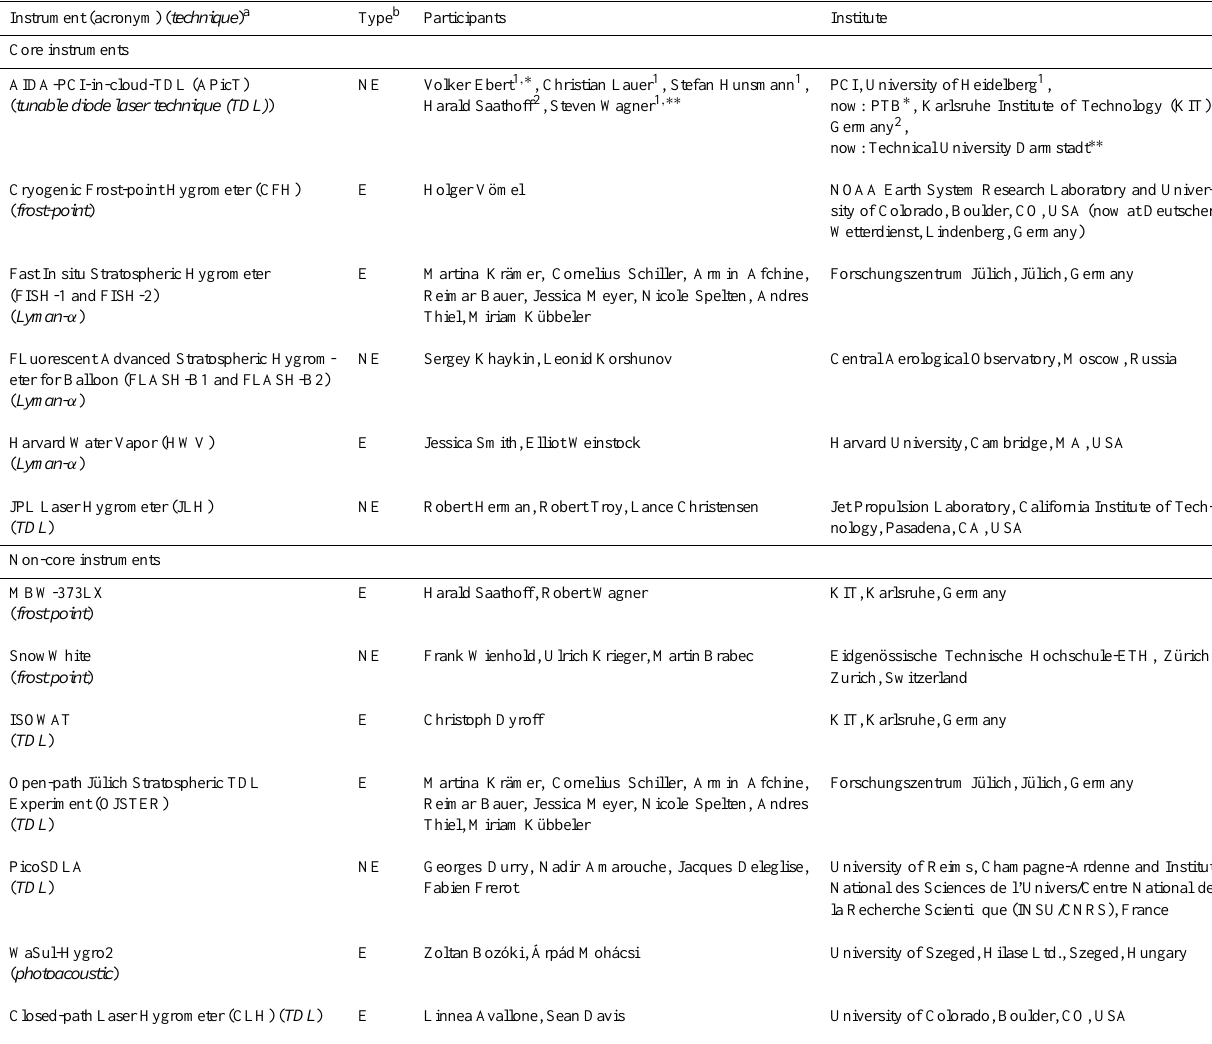
Table 1. AquaVIT-1 instruments, participants, and institutes. Instrument (acronym) ( technique )